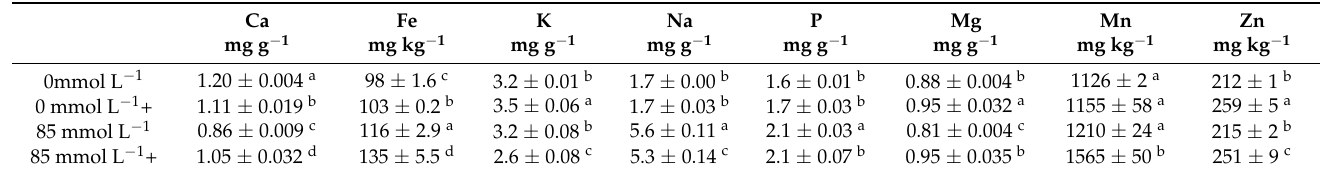
Table 2. Calcium, iron, potassium, sodium, phosphorus, magnesium, manganese, and zinc concen- trations in Swiss chard leaves after 30 d of treatment with 0 and 85 mmol L − 1 NaCl, non-inoculated and inoculated (+). Each value represents the mean of three replicates ± SE. Different letters indicate means that are significantly different from each other (ANOVA; Duncan test, p